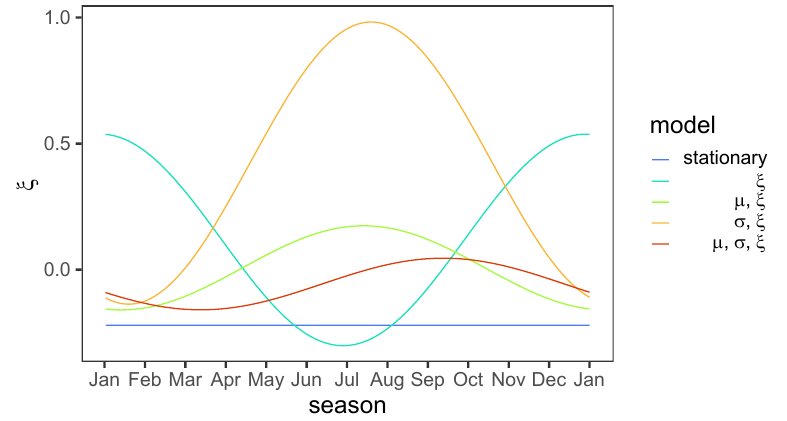
Figure A1. Shape parameter as a function of the season for different NHPP models for H S with season-dependent parameters. The models’ names indicate which parameters depend on the season. Comparison with Figure 2b reveals the incoherence of the last three